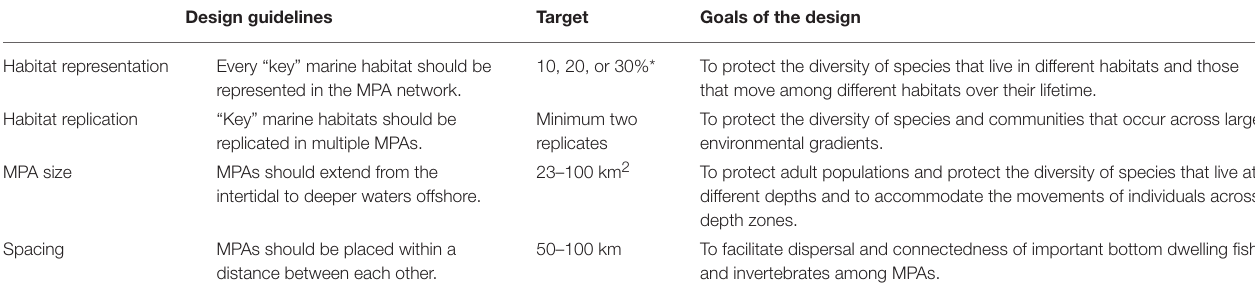
TABLE 1 | MPA network design guidelines (modified from Saarman et al., 2013) based on the MLPA scientific criteria and the conservation targets and design goals associated with each